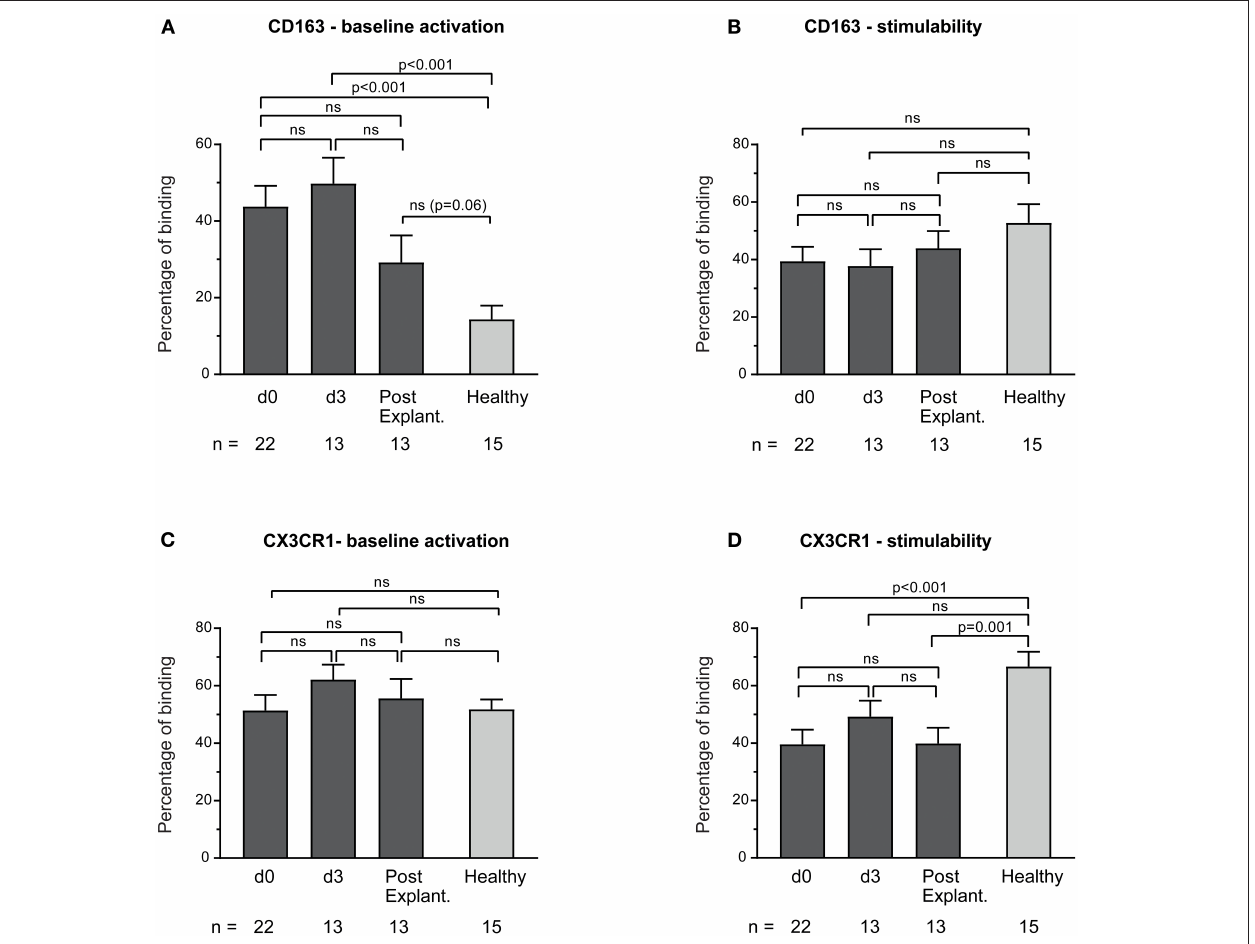
FIGURE 2 | Baseline monocyte activation and stimulability as determined by CD163 (A,B) and CX3CR1 (C,D) surface expression. The number of remaining patients analyzed at each time point during VA-ECMO therapy (d0, d3) and after explantation (post explant.) is presented below the individual bars. Baseline monocyte activation was measured in phosphate buffered saline treated samples. Stimulability was assessed in samples treated with phorbol 12-myristate 13-acetate to induce maximum monocyte activation. CD14 + monocyte CD163 and CX3CR1 expression is presented in percentage and was quantified as described in the Materials and Methods section. Mixed effects models were used to analyze differences between means across different time points (d0, d3, and post explantation vs. each other). Unpaired t -tests were used to analyze differences of means at single time points. ns, not significant. Data are presented as mean ±